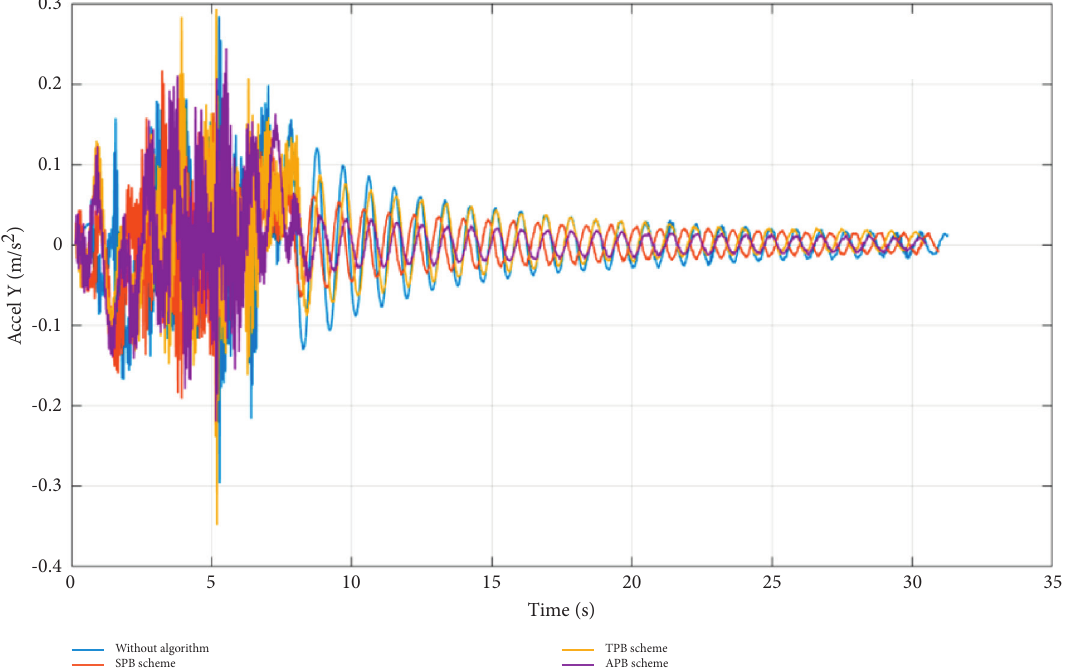
Figure 17: Comparison of test cases with various proposed